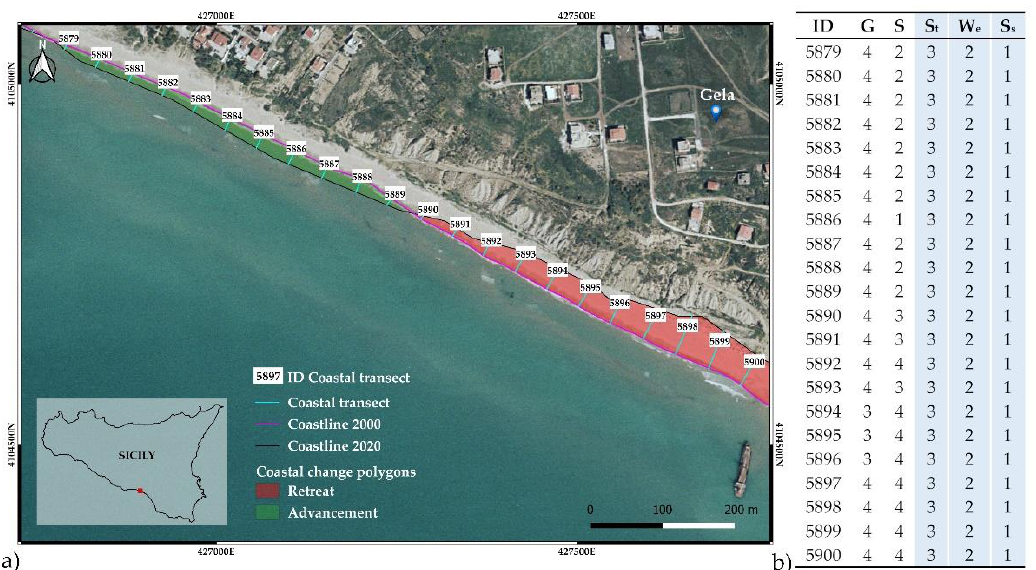
Figure 4. A coastal stretch of the Sicilian southern sector from LC 5.2. The orthophoto image corresponds to the year 2002 (ISPRA). Subplot ( a ) shows the polygons and related transects named with an ID. Subplot ( b ) shows a table linked to the indicator values for each transect. The red box on the south of the isle of Sicily represents the study area. The background image is the orthophoto “Volo IT2000” related to the year 2000 (EPSG: 32633).